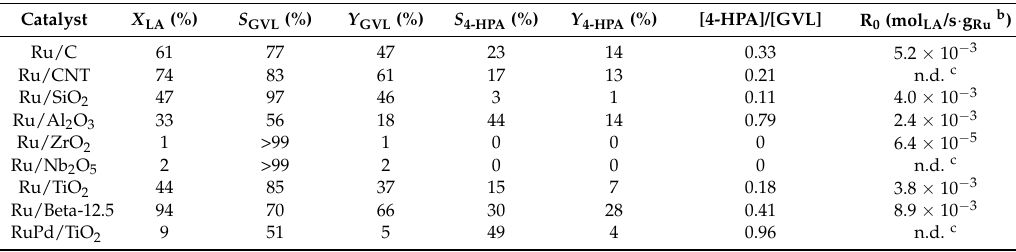
Table 4. Results of LA hydrogenation reaction in presence of ruthenium-based catalysts (1 wt. % Ru) in water in a batch set-up a .